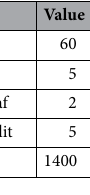
Table 3. Optimal parameters of the random forest model.